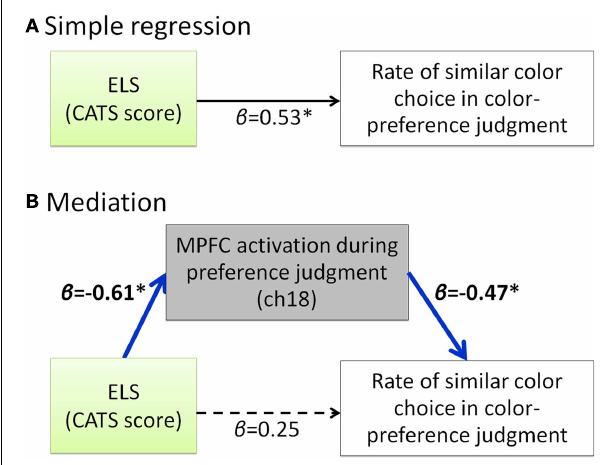
FIGURE 4 | Summary of the exploratory regression analyses about the relation among ELS, MPFC activity during color-preference judgment and the rate of similar color choice in color-preference judgment . (A) Path model between the ELS and the rate of similar color choice in color-preference judgment. (B) Path model in which the effect from the ELS to the rate of similar color choice in color-preference judgment is mediated by the MPFC activity during the color-preference judgment. β represents the standardized regression coefficient. *represents statistically significant β value ( p < 0.05). Dark blue arrows indicate the significant mediation effect. Dashed arrow represent not significant β value ( p > 0.05). ELS denotes early life stress. CATS denotes the Child Abuse andTrauma Scale. MPFC denotes medial prefrontal